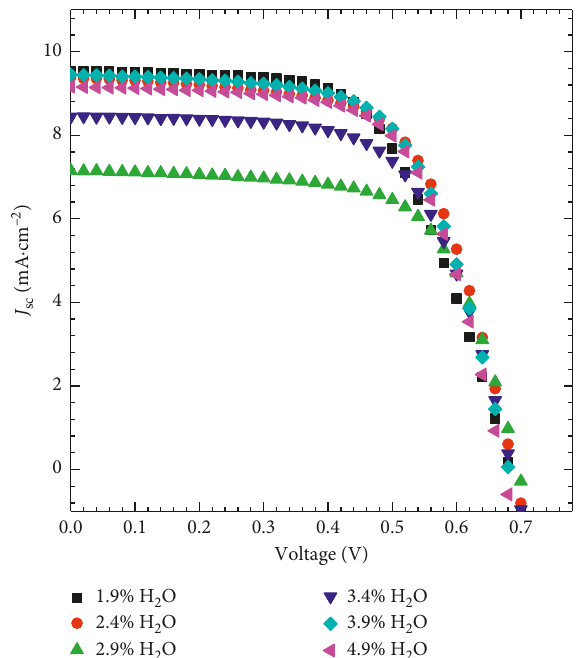
Figure 11: I-V curve of DSSC with n -type semiconductors pre- pared at different H 2 O concentrations and at a 2.5% HCl con- centration for the